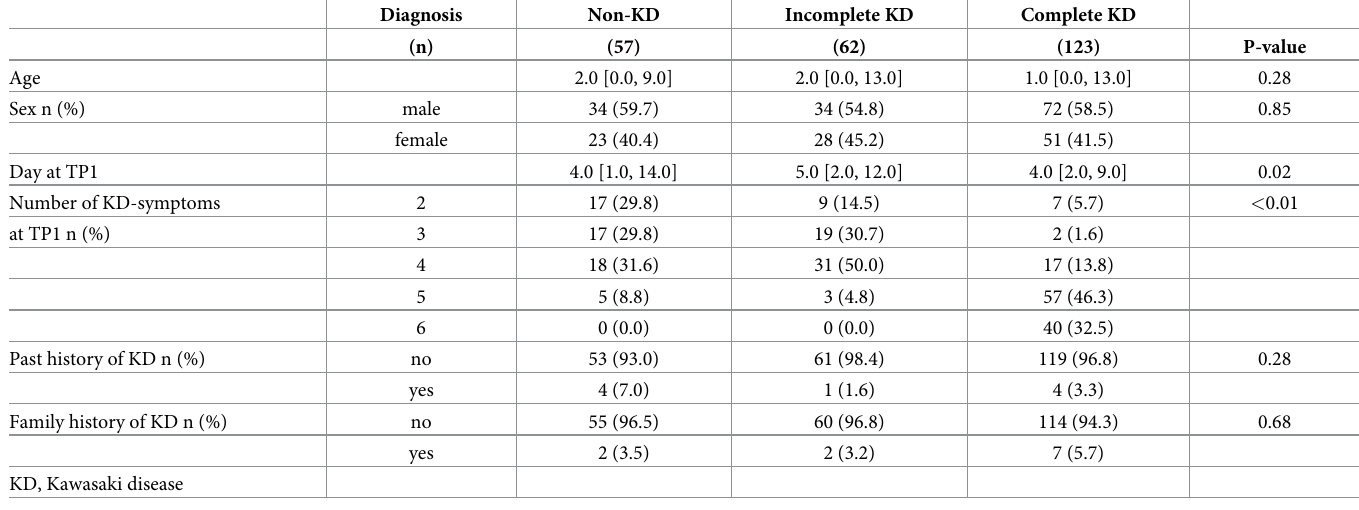
Table 1. Patient